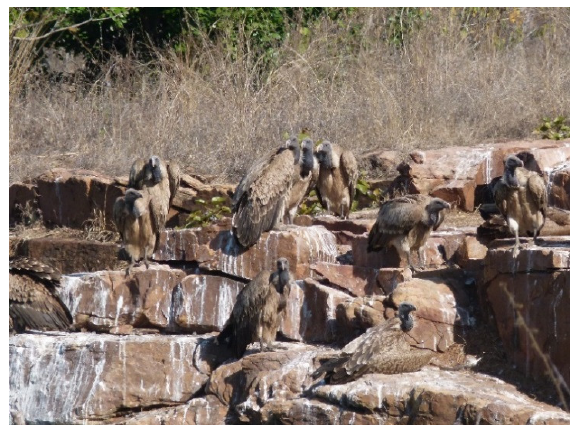
Figure 8. A group of cliff nesting, Critically Endangered, resident Indian or Long-billed Vulture Gyps indicus resting on ledges near permanent roosting location